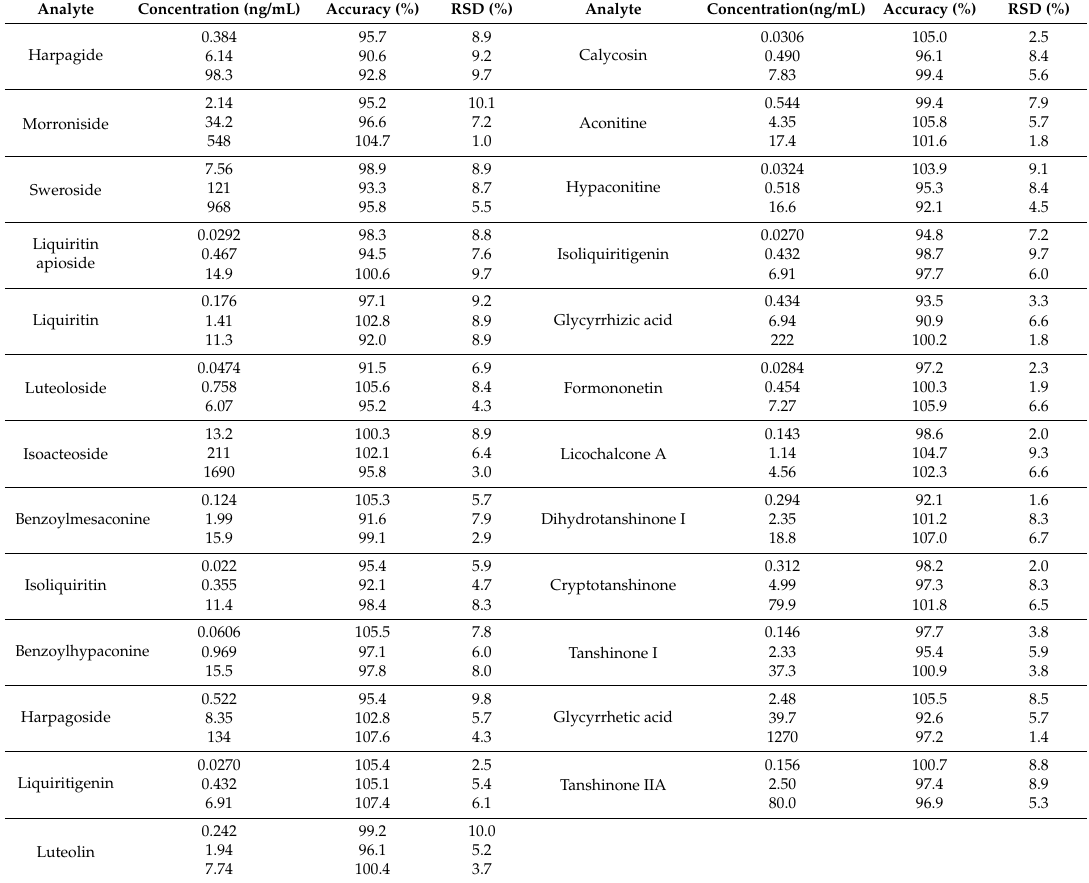
Table 5. Matrix effect data for the twenty-five analytes ( n = 6).